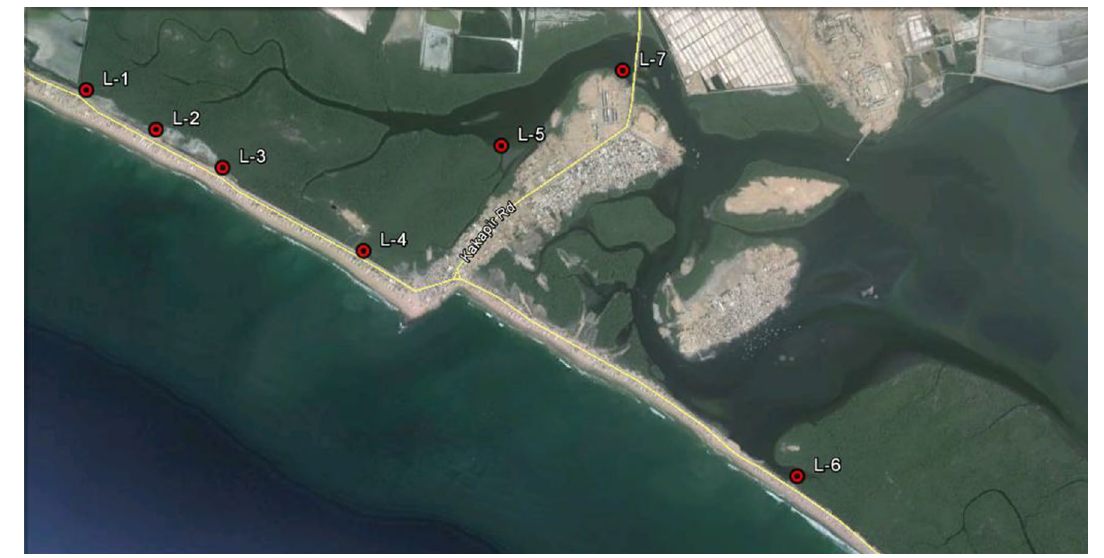
Fig. 1 Sites of sample collection Table 2 Descriptive statistics of physicochemical analysis western backwater,